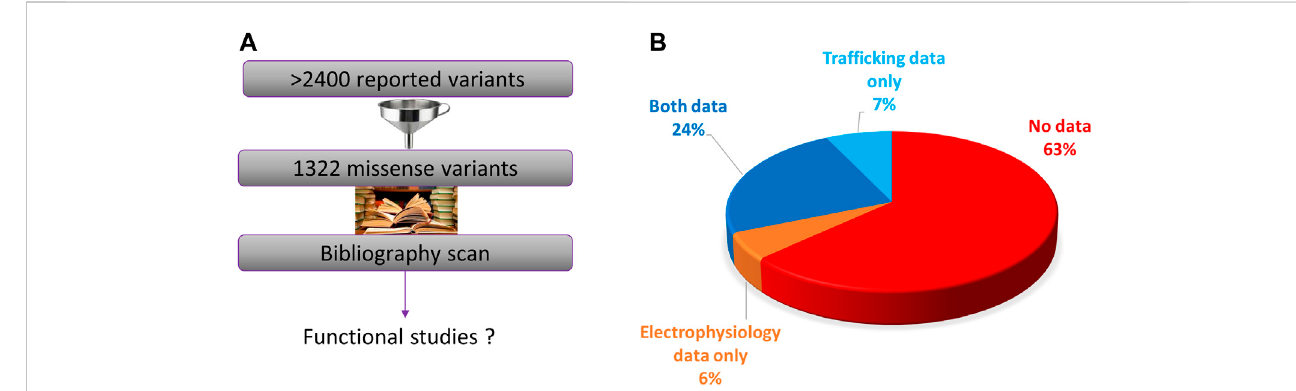
FIGURE 3 (A) . Diagram presenting the principle of the present literature analysis of all the hERG missense variants. (B) . Pie chart presenting the percentage of the variants that were not studied at all, studied in electrophysiology only, traf fi cking studies only, or both (from analysis of Supplemental Table